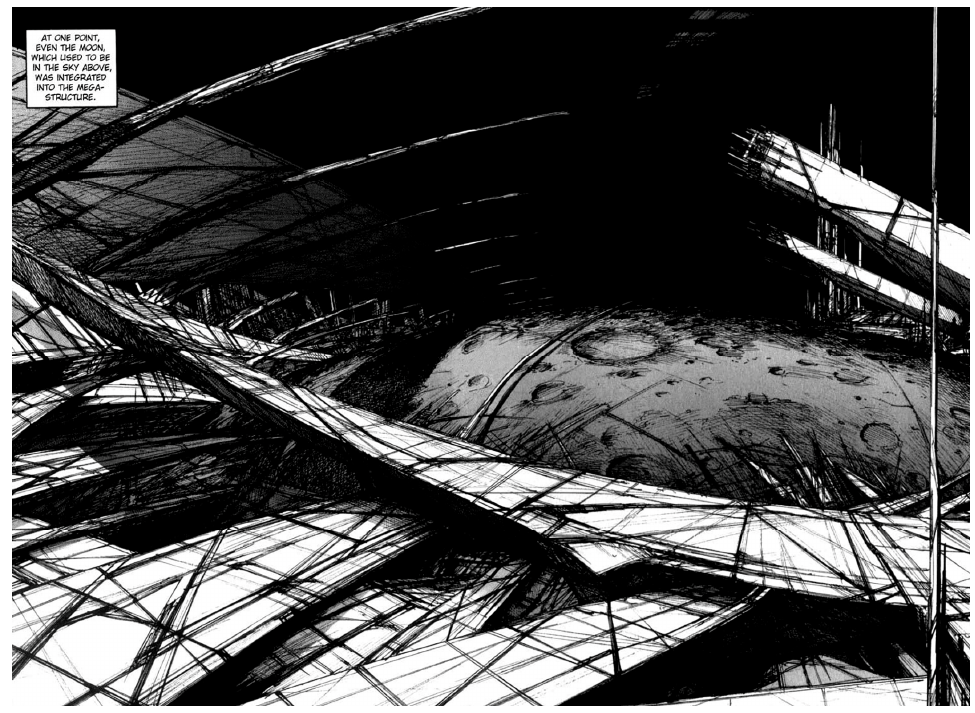
Figure 6. Tsutomu Nihei, NOiSE,